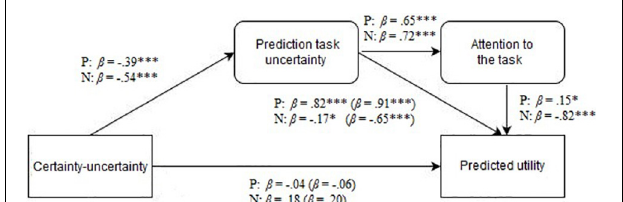
FIGURE 4 | Testing the effect of prediction task uncertainty and attention to the task on predicted utility. β refers to the standardized regression coefficient for the positive (P) and negative (N) utility conditions. The standardized regression coefficients without attention (for prediction task uncertainty) or with prediction task uncertainty and without attention (for certainty–uncertainty) are shown in parentheses. ∗ p < 0.05, ∗∗ p < 0.01, ∗∗∗ p <